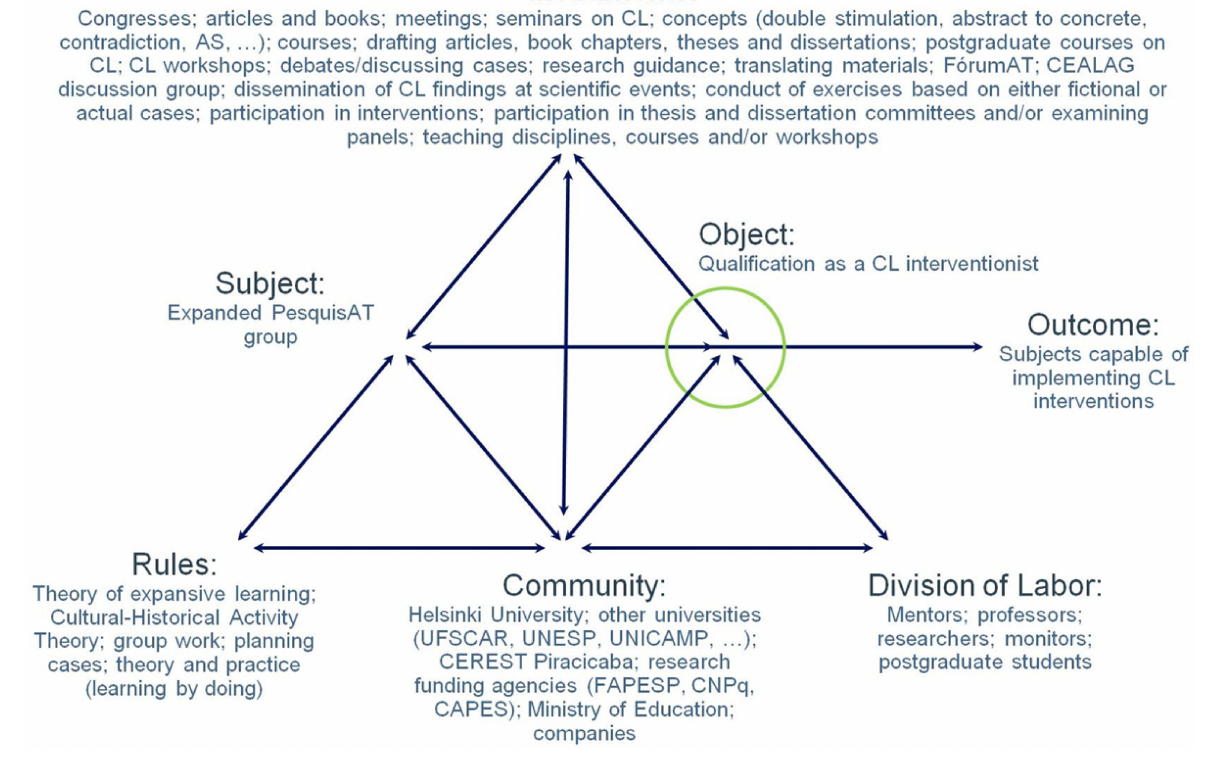
began, there were few publications on CL written in